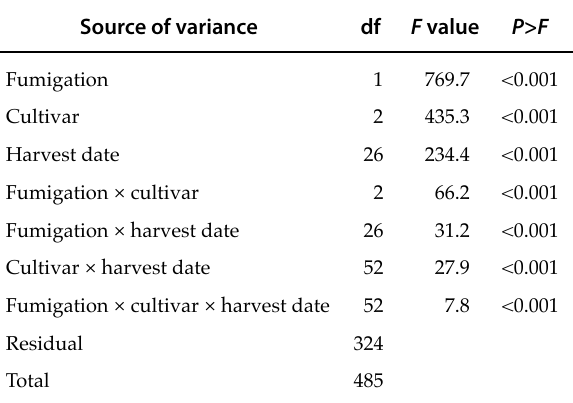
Table 2. Analysis of variance for yields of strawberry culti- vars in relation to fumigation, cultivar and harvest date in the field experiment in Wanneroo, Western Australia.